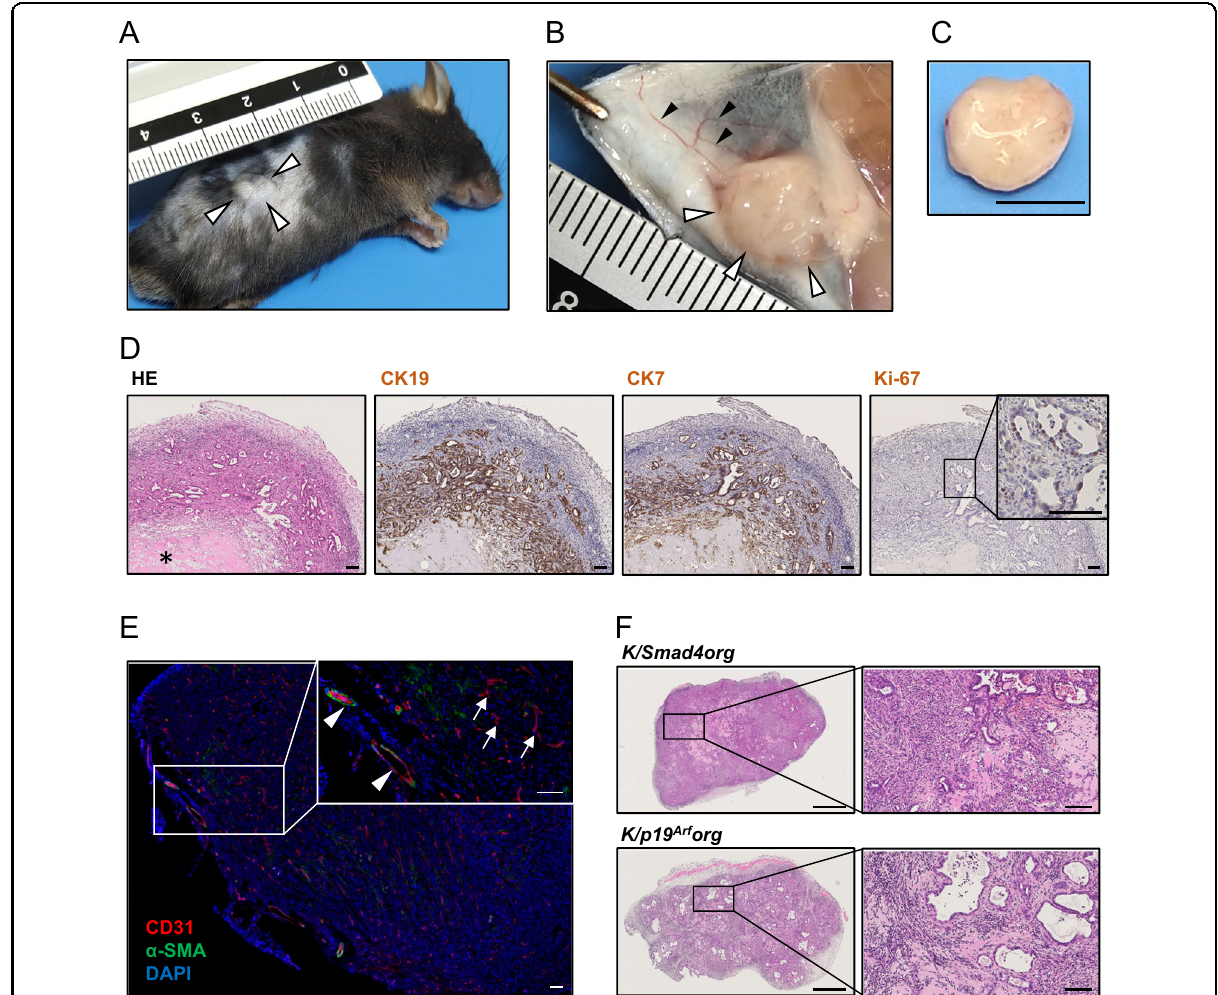
Fig. 2 Subcutaneous tumor development from gall bladder (GB) organoids in syngeneic mice. A Macroscopic view of a subcutaneous tumor in a WT C57BL/6 J mouse. A representative image of a subcutaneous tumor (open arrowhead) derived from injected K/53 org is shown. B Neo- angiogenesis in the tumor. Induction of surrounding blood vessels (closed arrowhead) into the tumor (open arrowhead) is shown. C An isolated subcutaneous tumor. Scale bar, 5 mm. D Histological fi ndings and immunohistochemical staining of K/53 org subcutaneous tumor. Note that hyalinization of the stroma (asterisk) is indicative of central necrosis. Scale bar, 100 μ m. E Immuno fl uorescence staining of tumor vessels. Left, vascular endothelial cells (red, CD31) and pericytes (green, alpha smooth muscle actin [ α -SMA]) are stained. The nucleus (blue) is visualized by DAPI. Scale bar, 500 μ m. Right, vessels outside the tumor covered by α -SMA-positive cells (arrowhead) and uncovered vessels in the tumor (arrow). Scale bar, 100 μ m. F Histological fi ndings of subcutaneous tumors. K/Smad4org, Korg with Smad4 knockout. K/p19 Arf org, Korg with p19 Arf knockout. Scale bar, 500 μ m (low magni fi cation), 100 μ m (high magni fi